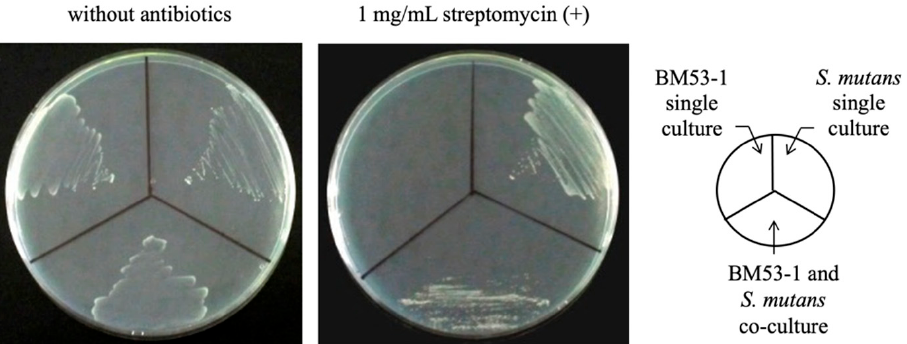
Figure 2. Confirmation of living S. mutans cells after co-cultivation with Lb. reuteri BM53-1. The aliquot of co-cultured broth was plated onto MRS agar with or without 1 mg/mL streptomycin. The single cultured broth of each strain was also plated for the control.